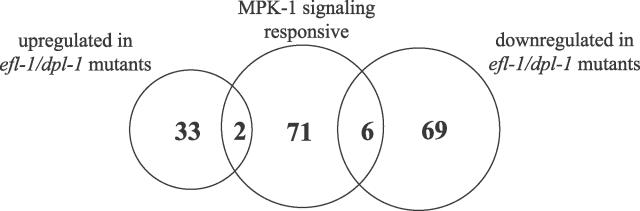
MPK-1 and EFL-1/DPL-1 Do Not Regulate the Same Set of Genes in the Germ LineMPK-1 signaling-responsive genes identified in this study have minimal overlap with candidate down-regulated or up-regulated EFL-1/DPL-1-responsive genes (Table S1).